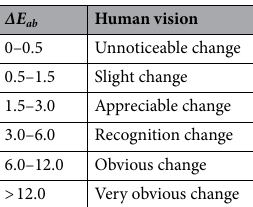
Figure 5. ( a ) The colours of the R-PTC surface changed from light-red (below 38 °C) to dark-red (above 42 °C). ( b ) The curve of ∆E ab . ( c ) The colours of the R-PTC surface changed before and after ultraviolet light treatment. ( d ) The thermochromic mechanism of R-TD.